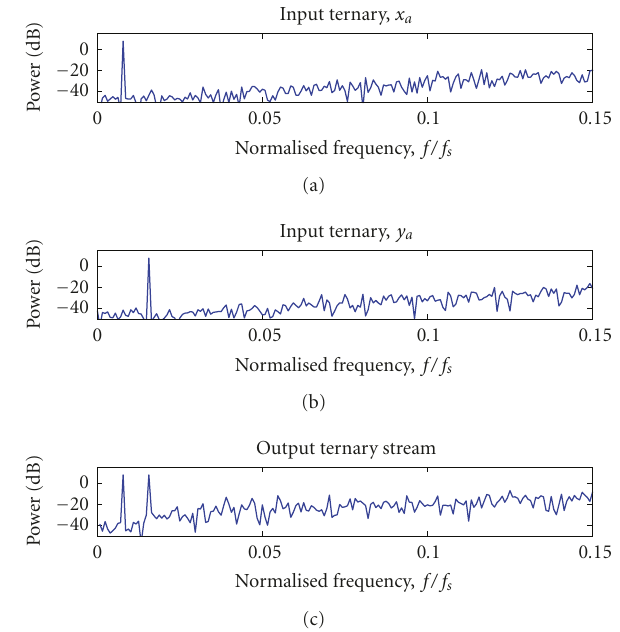
Figure 4: The spectra of the input ternary streams and their ternary summation.